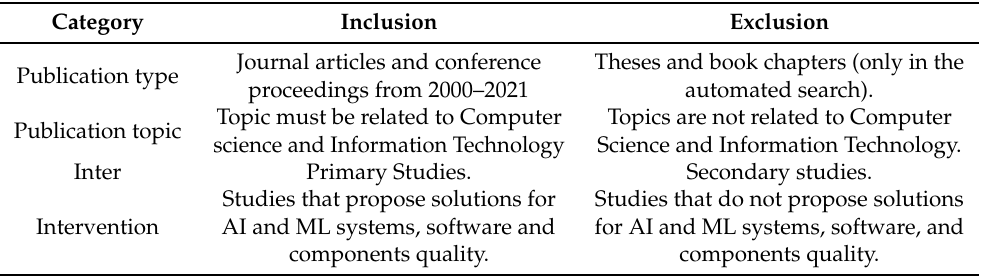
Table 4. Inclusion and Exclusion